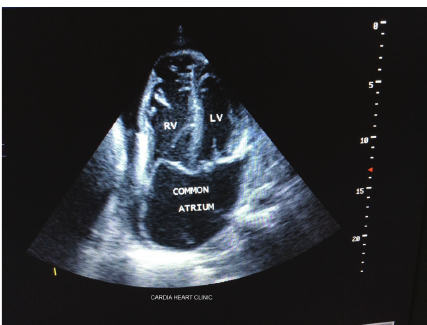
Figure 1: Two-dimensional echocardiogram apical 4-chamber view of the common atrium.